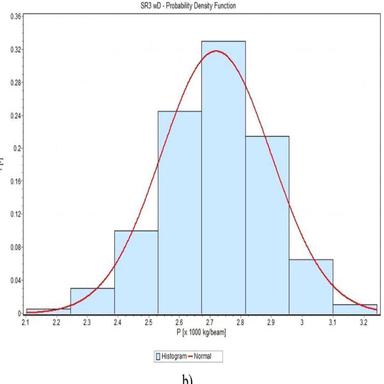
Histogram of system strength for: a) Rack frame SR5 and b) Rack Frame SR3wD.